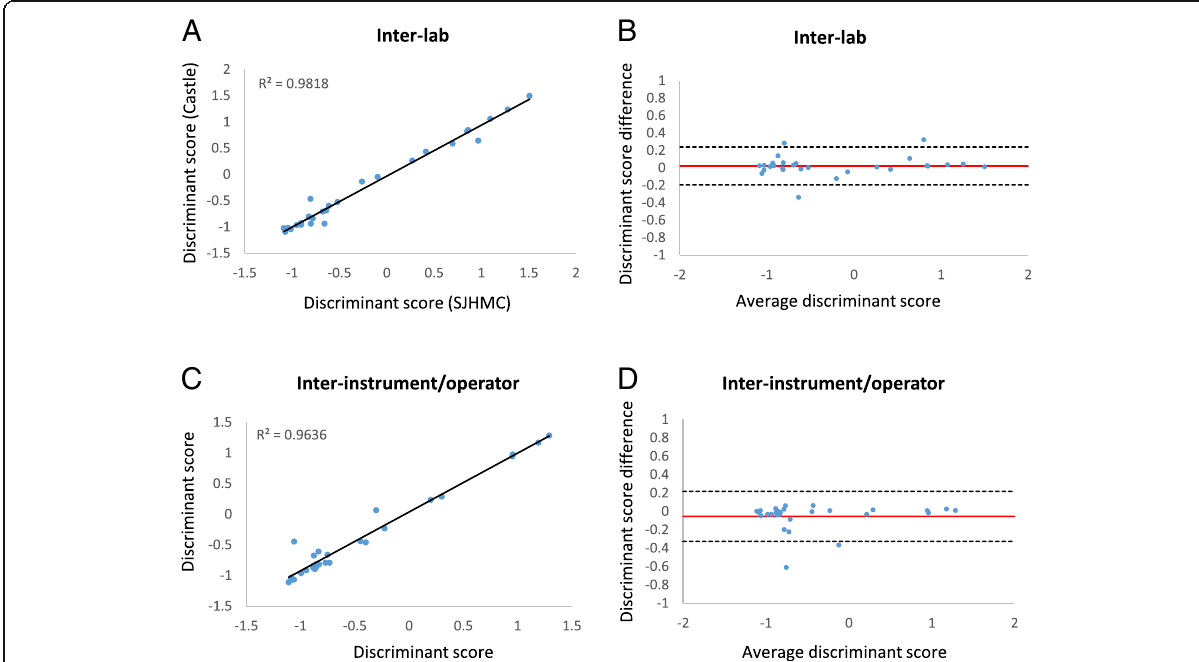
Fig. 3 Inter-lab and inter-instrument/operator reliability of DecisionDx-UM. a Correlation of 29 paired discriminant scores from samples run at two CLIA-certified laboratories. b Bland-Altman plot of the estimated bias (average difference between discriminant scores, red line ) between labs and the 95% confidence interval ( dashed lines ). c Correlation analysis of 28 paired inter-instrument/operator discriminant values. d Bland-Altman plot paired inter-instrument/operator discriminant